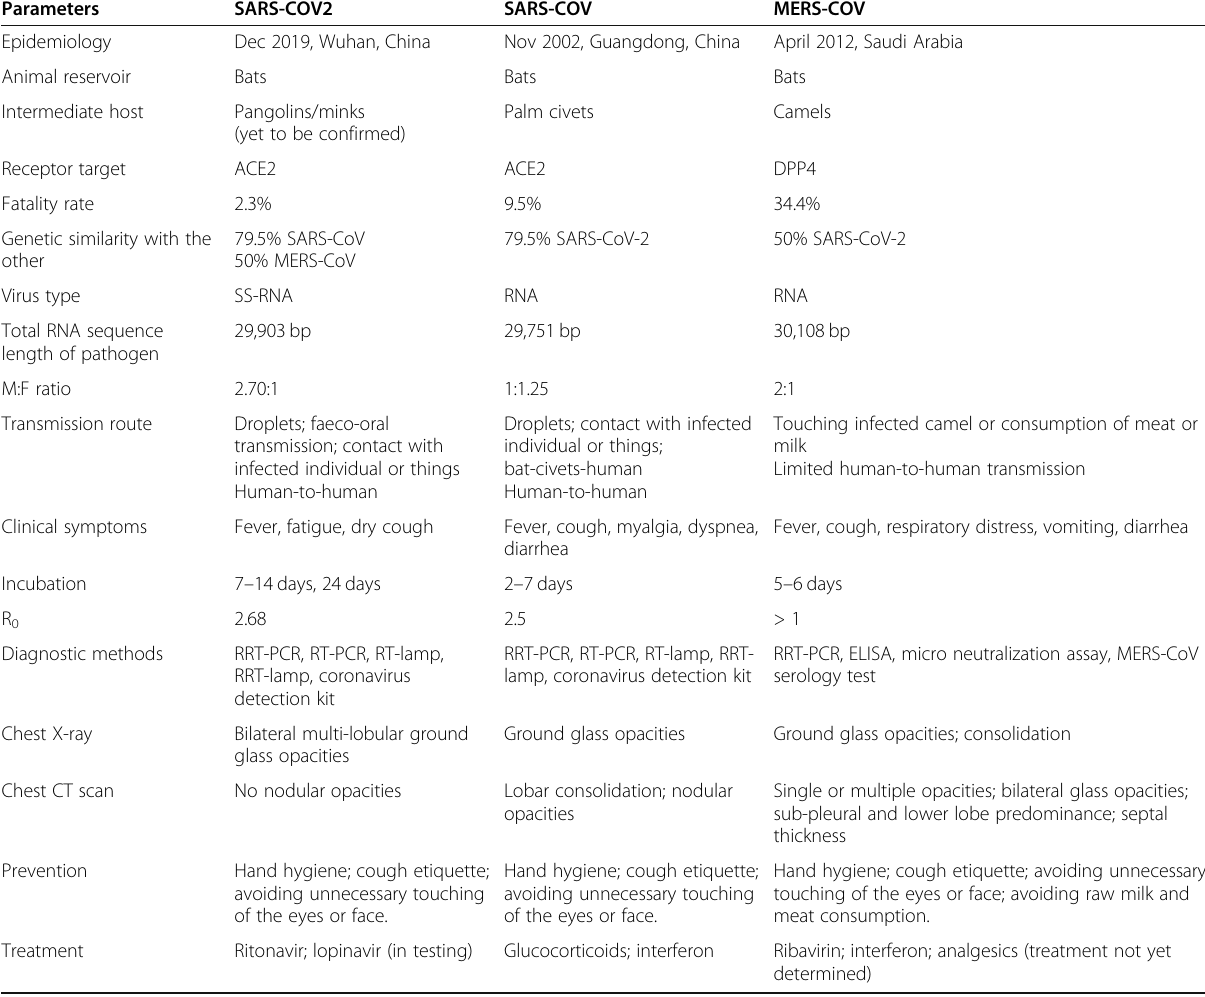
Table 1 Comparison of